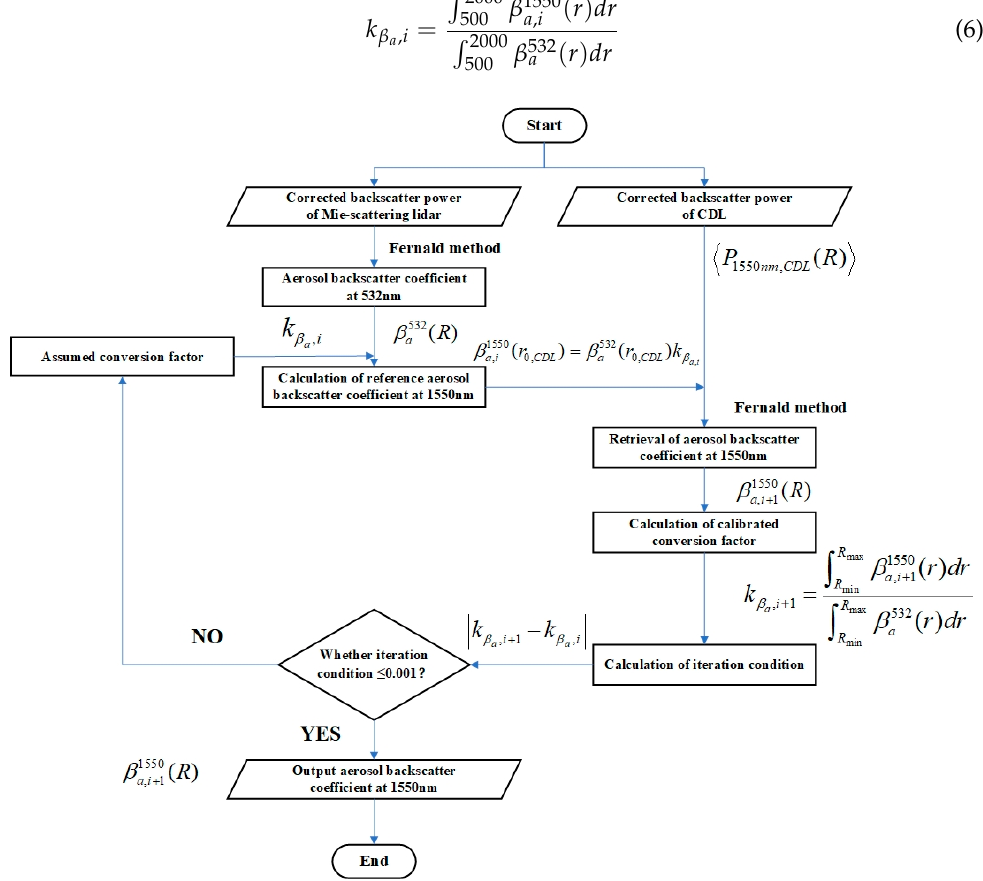
Figure 1. Overview of the iteration procedure.